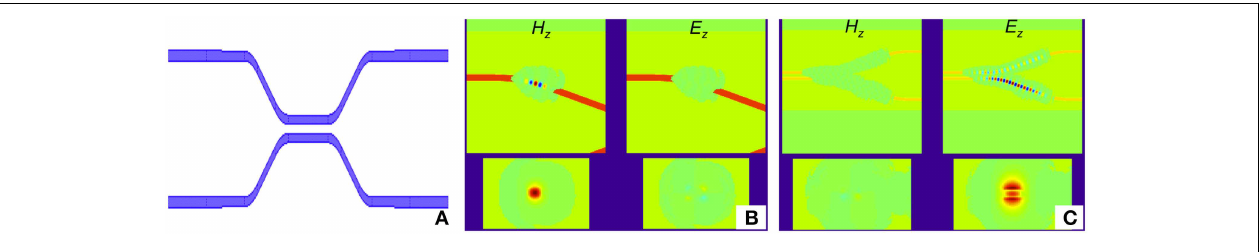
FIGURE 13 | Simulation results from 3D sparse FDTD. (A) is the top view of the structure being simulated, which is a directional coupler. (B) Shows a screen shot from a simulation using a quasi-TE launch. The top two